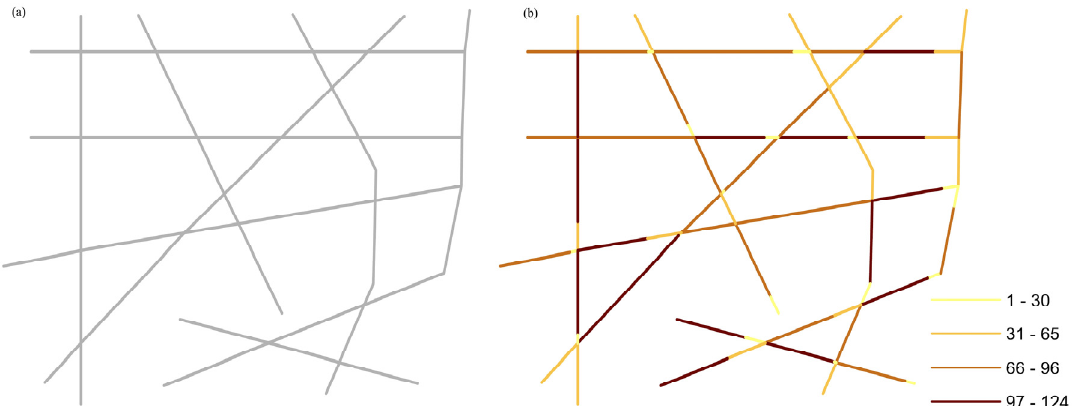
Figure 3. The spatial distribution of the hypothetical network and simulated network events: ( a ) a 10- km hypothetical network; ( b ) the number of randomly distributed 5000 network events along 80 BSUs.